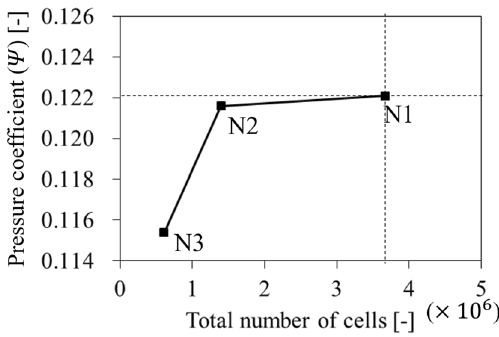
Figure 5. Result of grid test based on grid convergence index